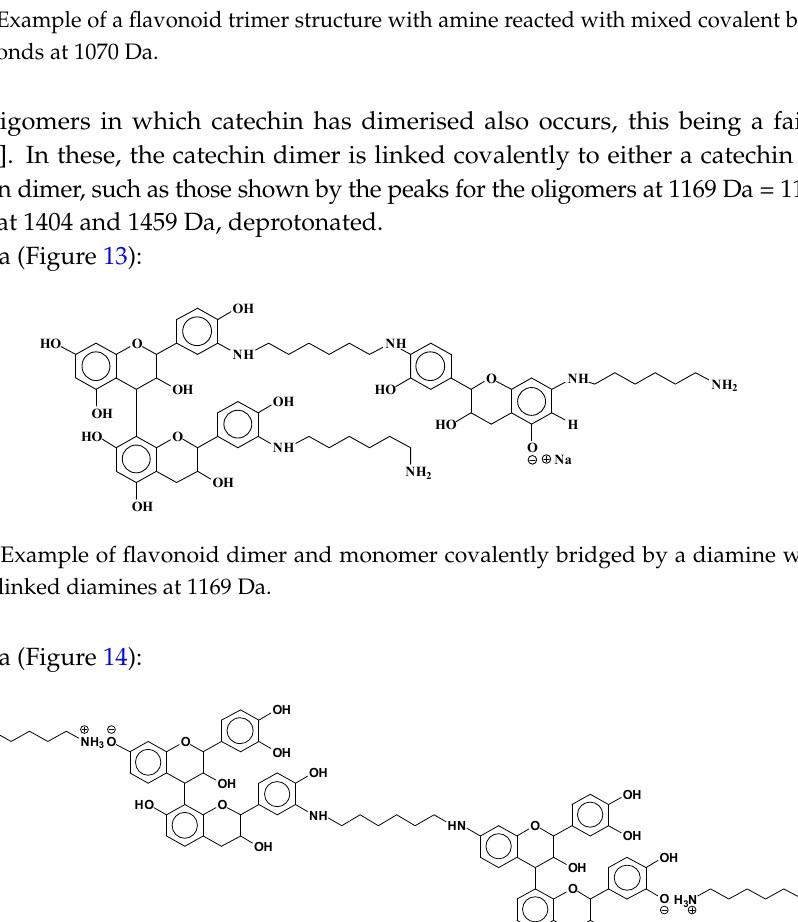
Figure 14. Example of two flavonoid dimers covalently bridged by a diamine with other ionic salt bonds linked diamines at 1404 Da.